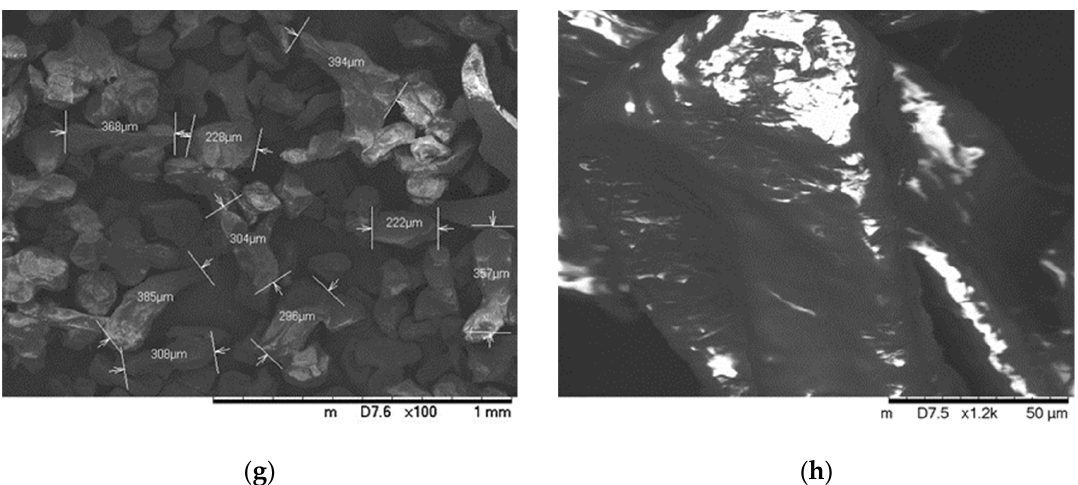
Figure 3. Determination of diameter of wet alginate microcapsules: ( a ) Light microscopic image of wet uncoated alginate microcapsules. The average size was 412.54 ± 28.83 µm. ( b ) SEM images of freeze-dried uncoated alginate microcapsules. ( c , d ) Shape and surface of uncoated alginate microcapsules, ( e , f ) chitosan-coated alginate microcapsules, and ( g , h ) Eudragit L100-55-coated microcapsules by SEM. The average size was determined by using 50 microcapsules.